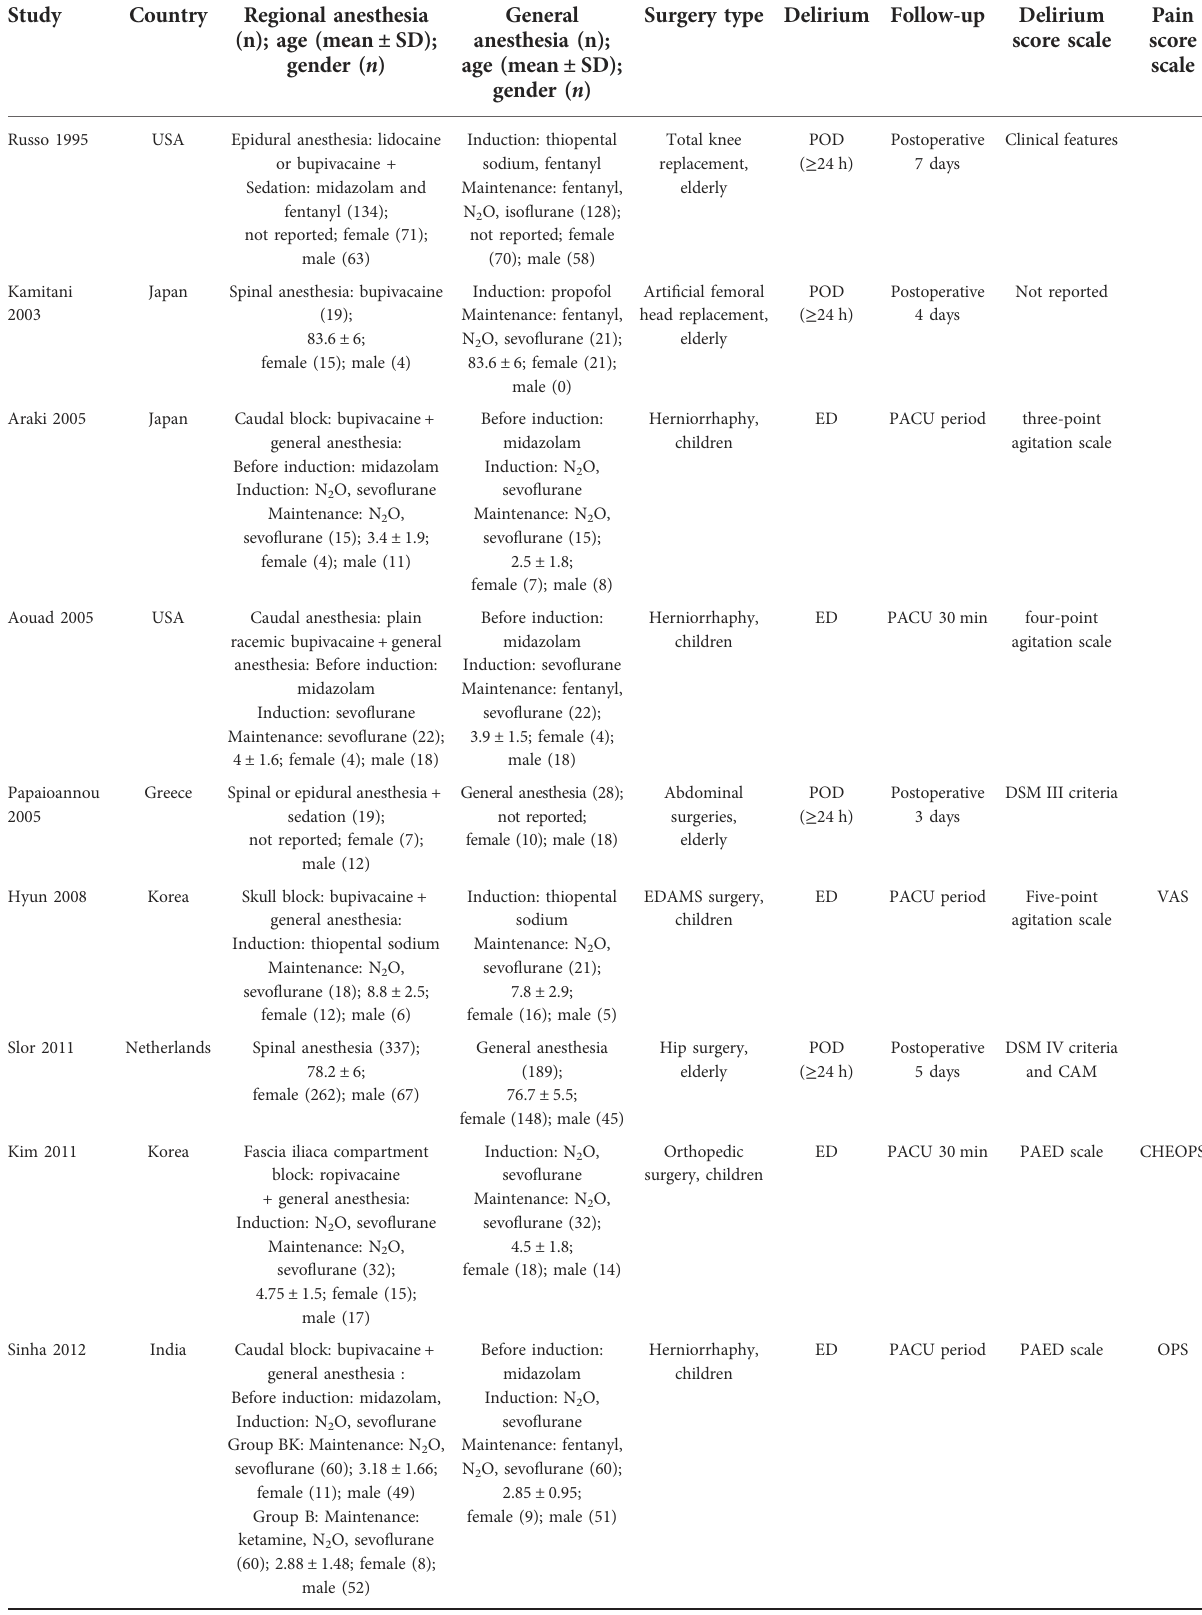
TABLE 1 Characteristics of the included studies.